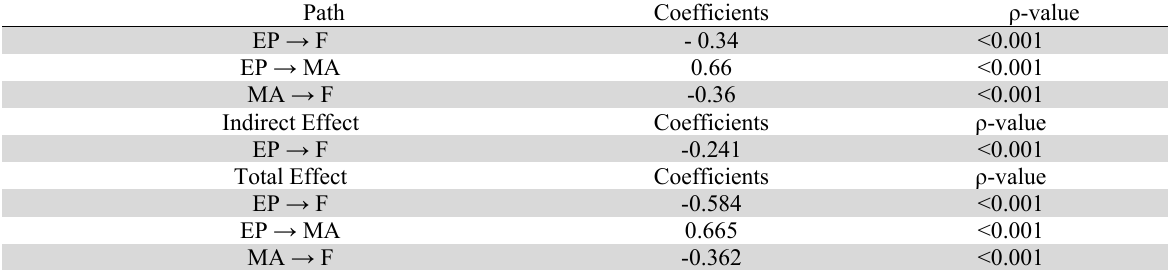
Path Coefficients, ρ -Value, Indirect Effect, Total Effect-Full